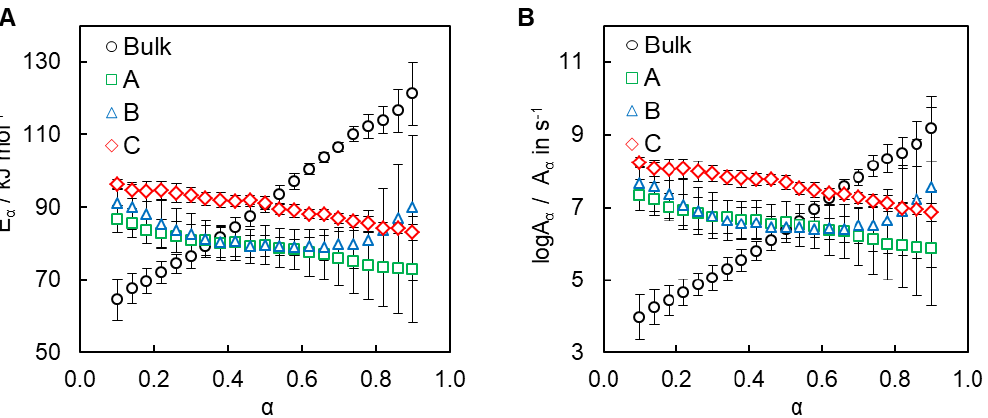
Figure 8. Dependencies of activation energy ( A ) and pre-exponential factor ( B ) as a function of conversion for polymerization of bulk and confined cyanate ester.